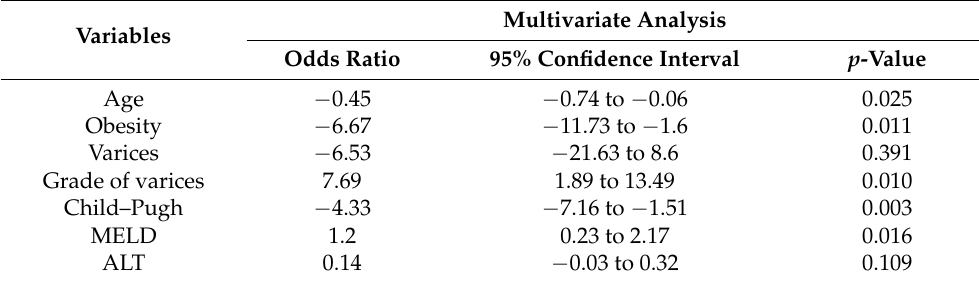
Table 3. Significant factors in the multivariate analysis for osteoporosis in liver cirrhosis patients.